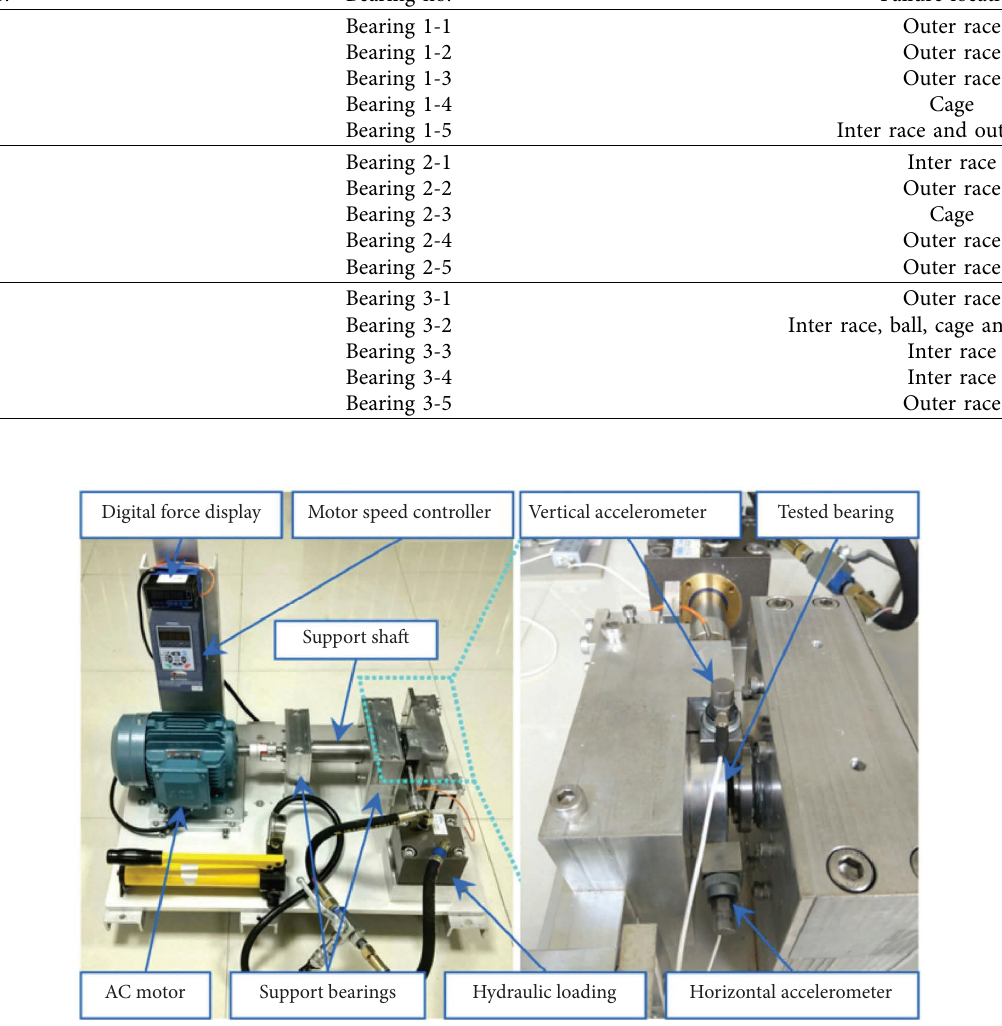
Figure 6: Testbed of rolling element